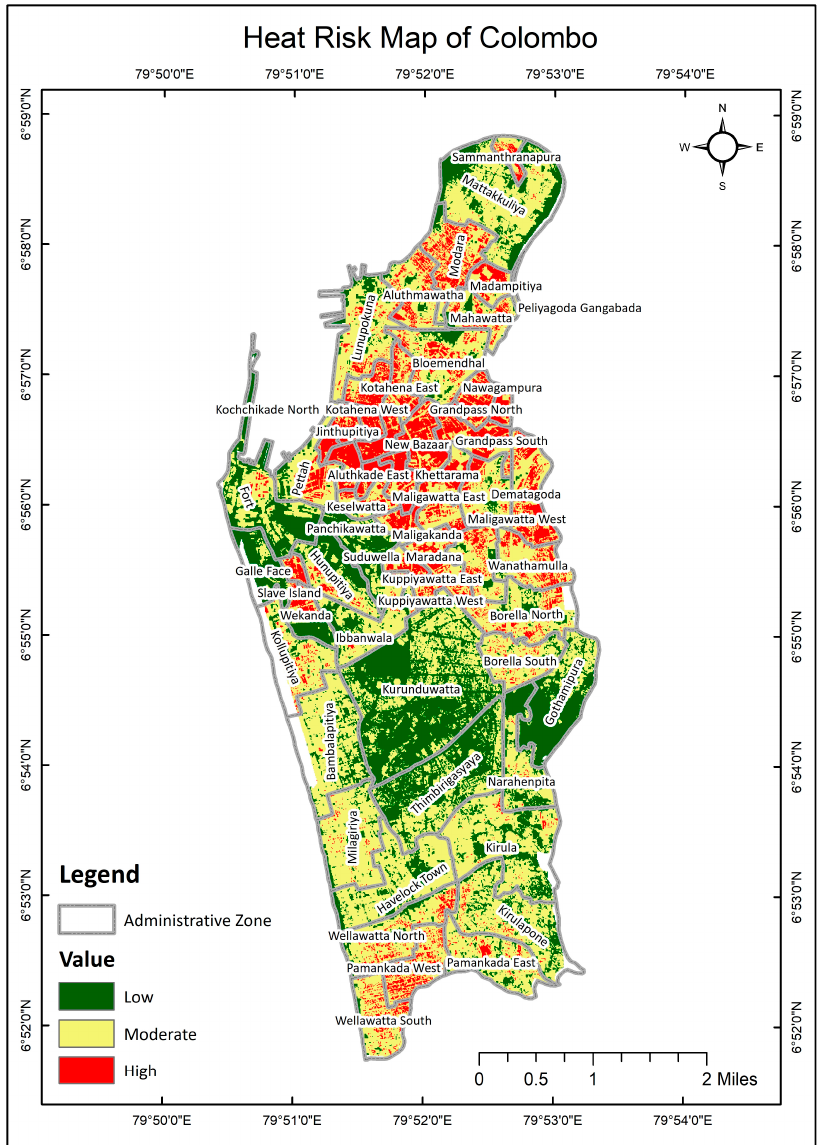
Figure 8. Heat risk map for Colombo, Sri Lanka.